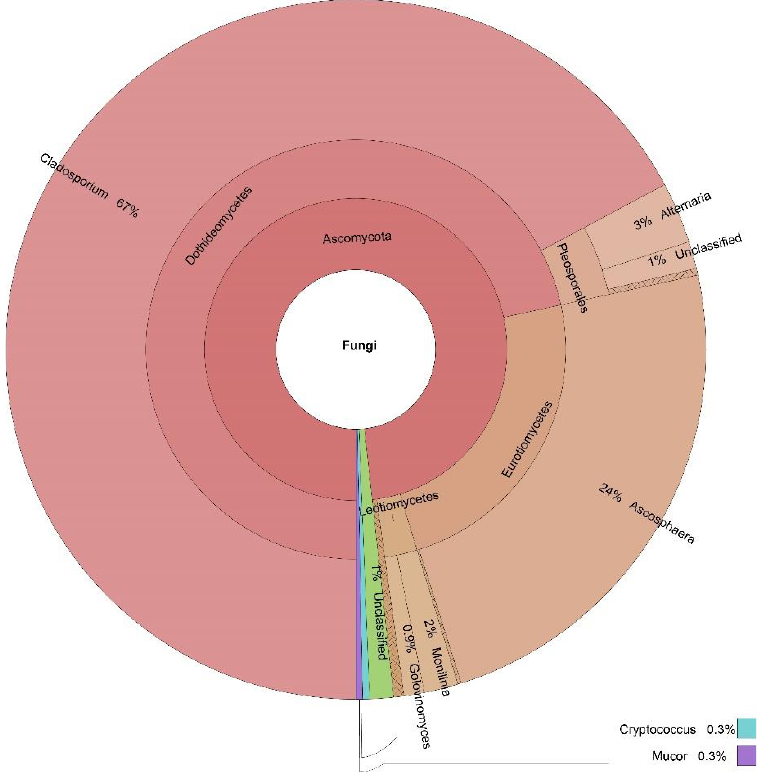
Figure 4 . Krona display of the fungal composition of the samples from Sofia. Figure 4. Krona display of the fungal composition of the samples from